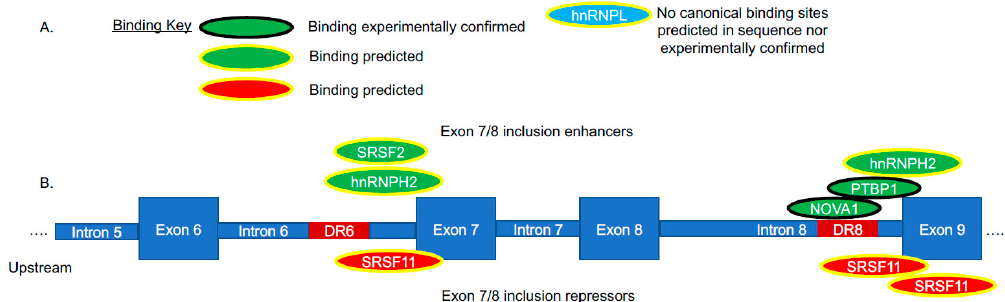
Figure 4. Reverse transcriptase alternative splicing regulation of hTERT. ( A ) Key of RNA binding proteins associated with hTERT. Enhancers are depicted in green. Repressors in red. Blue indicates a likely indirect impact on TERT splicing caused by the manipulation of a splicing factor. ( B ) Cartoon image of introns 5 through exon 9 of hTERT in the reverse transcriptase domain (RT). On top of the cartoon image are the hTERT exon 7 / 8 enhancers. On the bottom are the proteins that repress the inclusion of exons 7/8.